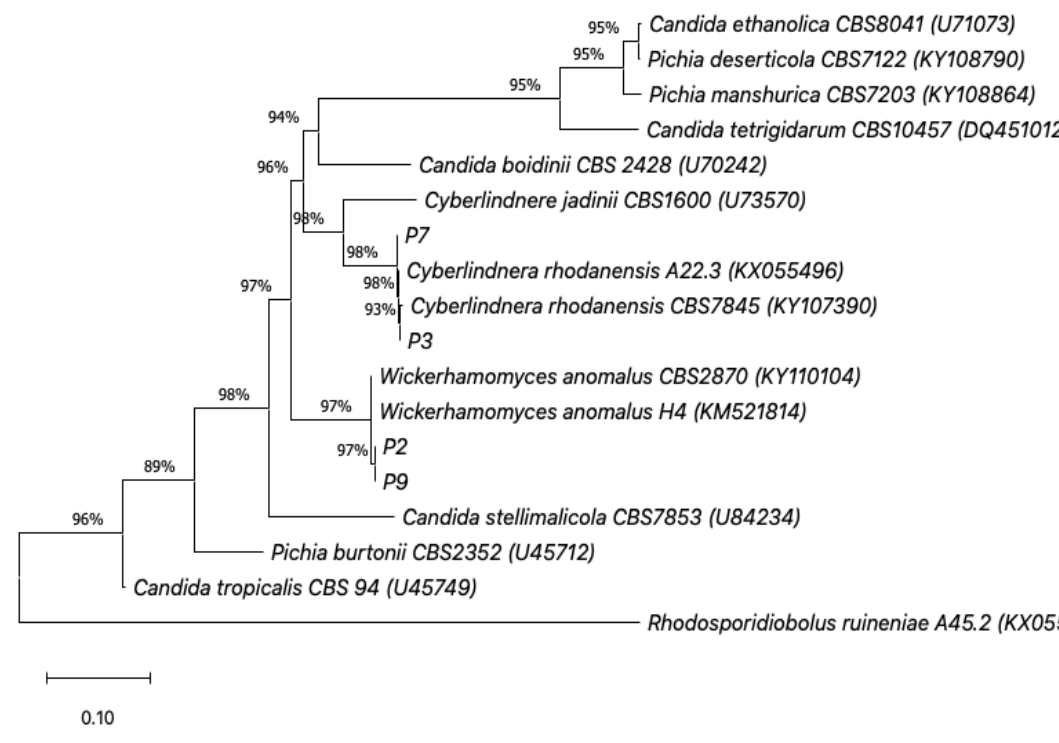
Figure 3. Phylogenetic tree analysis of the yeast Cyberlindera rhodanensis P3 and P7, Wikerhamomyces anomalus P2 and P9, based on particle 26S rDNA D1/D2 region sequence using the neighbor-joining method. Bootstrap values >50% (based on 1000 replication) are given at the branch points. The scale bar shows a patristic distance of 0.10.